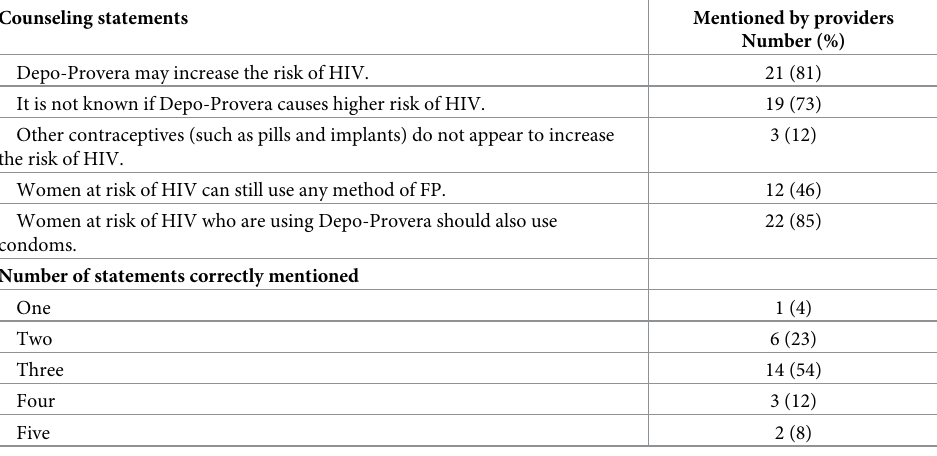
Table 6. Providers’ knowledge of HC-HIV counseling messages: Spontaneous response number and percent dis- tribution of knowledge of HC-HIV counseling messages among twenty-six trained healthcare providers, Tanzania